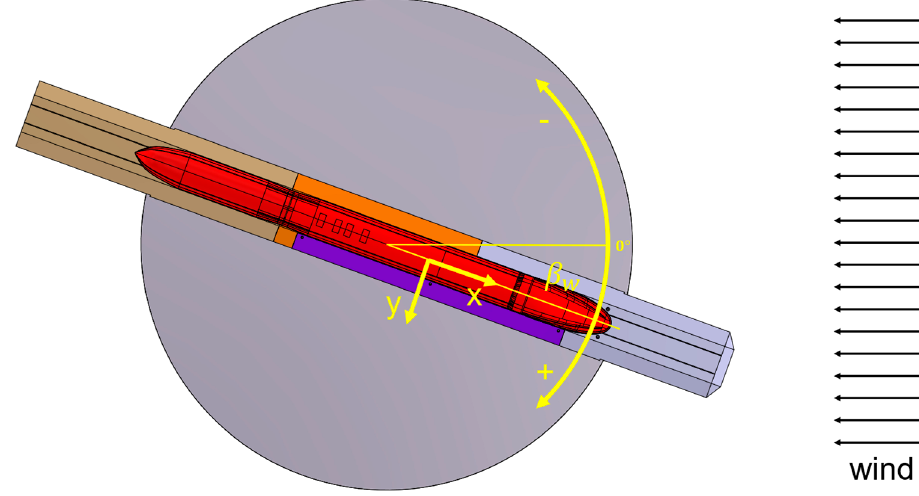
Figure 5. Reference system for wind tunnel test.